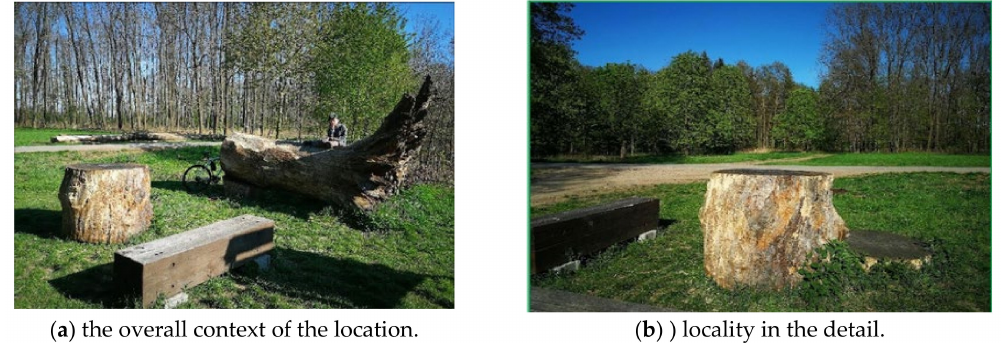
Figure 5. ( a , b ) Resting place on the Židlochovice-Velk é Nˇemˇcice cycle path (valuable place—open